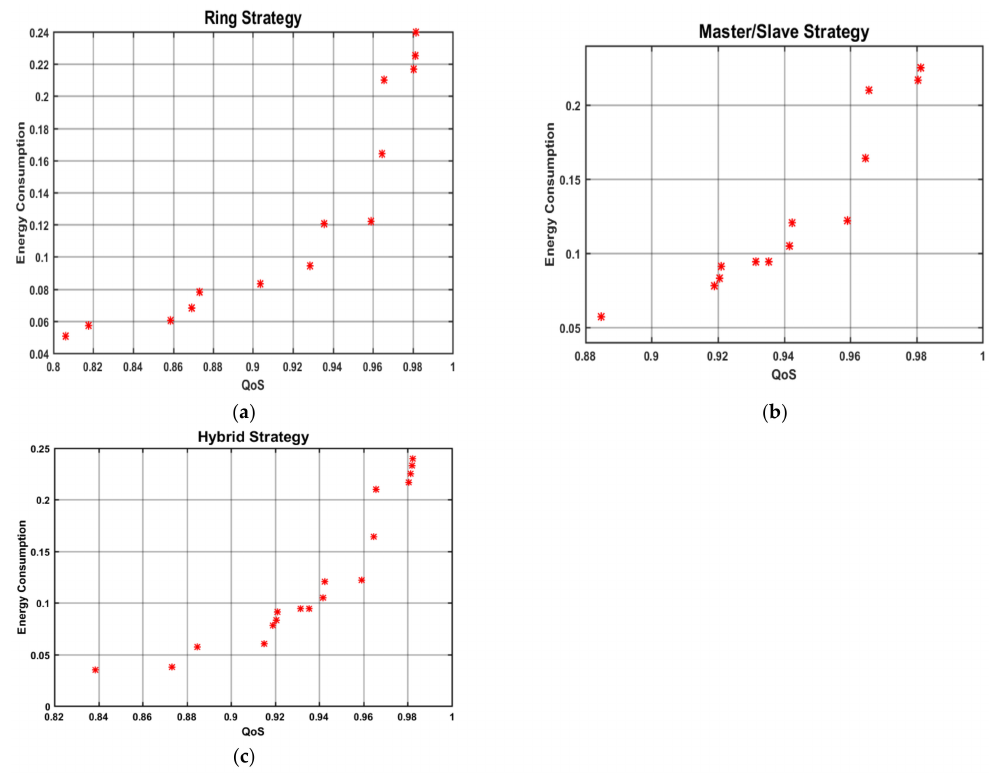
Figure 14. Pareto Optimal for Qos score and energy consumption in different strategies agents ( a ) Ring; ( b ) Master/Slave; ( c )